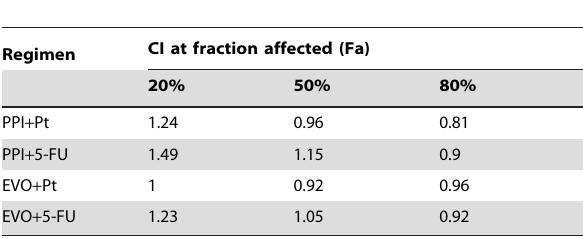
Table 3. Summary of CI values at 20, 50 and 80% fraction